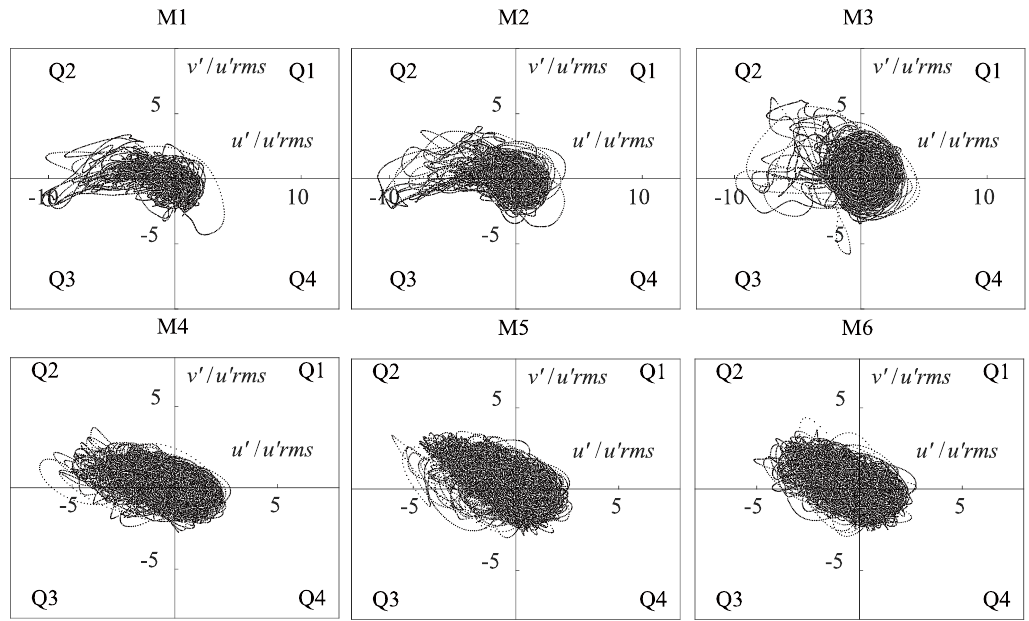
Figure 10. Quadrant analysis of the streamwise and spanwise velocity fluctuations normalized by u’ rms for Case 1 at z / H = 0.93; Q1–Q4 represent the four quadrants, respectively.